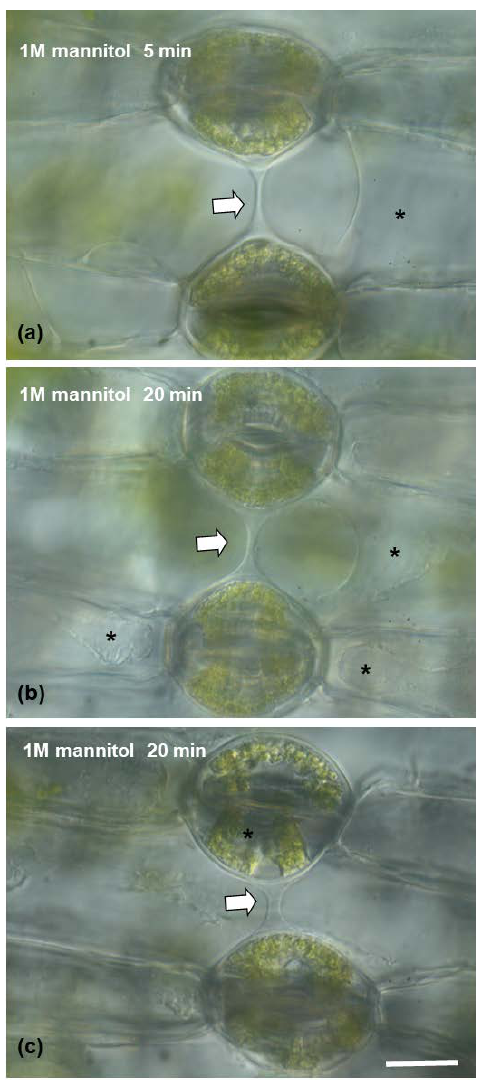
Figure 8. ( a – c ) Light micrographs of epidermal peels with DIC (Nomarski) optics, showing the connection strand (arrow), which retains its structural integrity in the presence of a hypertonic 1 M mannitol aqueous solution after 5 ( a ) or 20 ( b , c ) minutes. The connection strand is present, while the cytoplasm of the epidermal ( a , b ) or guard cells ( c ) appears plasmolyzed (asterisks). Scale bar: 20 μm.